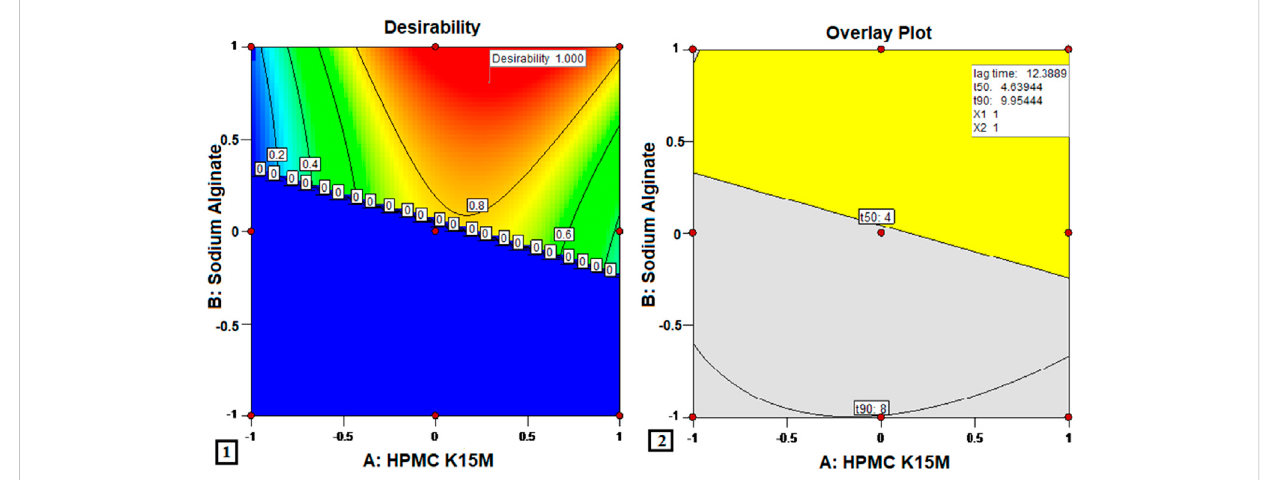
FIGURE 4 Optimization of MTG fl oating matrix tablet (1) desirability function and (2) overlay plot.